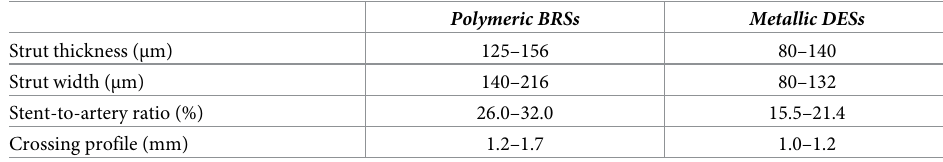
Table 1. Comparison of strut geometry and performance metrics of clinically tested bioresorbable stents ( BRSs ) and modern metallic drug-eluting stents ( DESs ) for coronary application